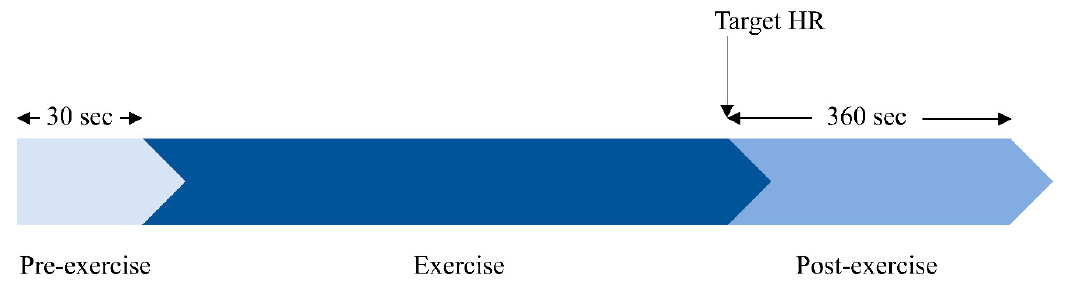
Figure 1. Study protocol showing pre-exercise, exercise and post-exercise phases.